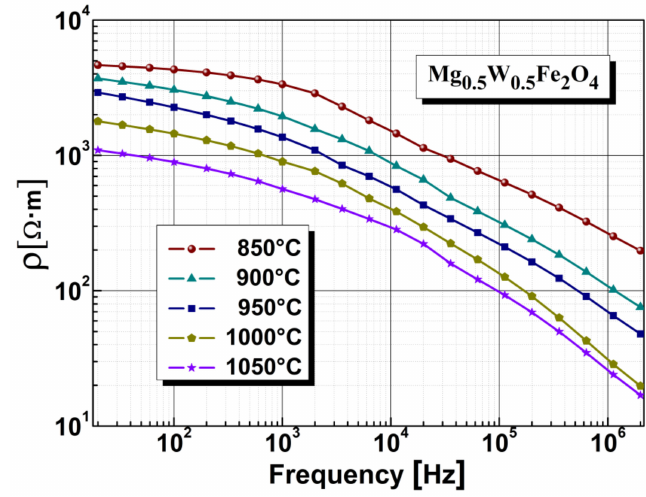
Figure 4. The influence of annealing temperature on electrical resistivity.